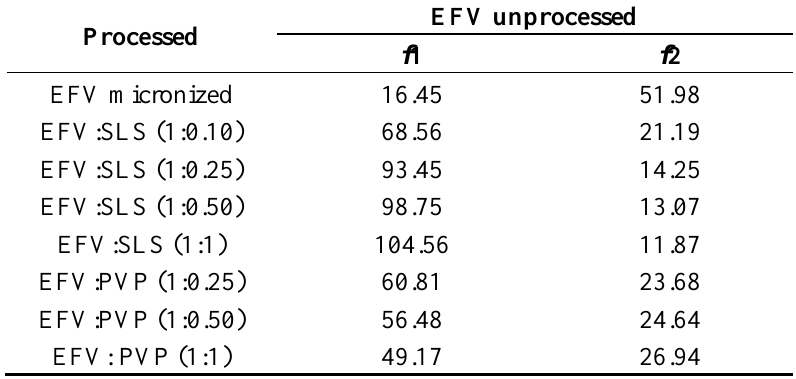
Table 3. Values of f 1 and f 2 found for processed samples compared to the unprocessed drug .